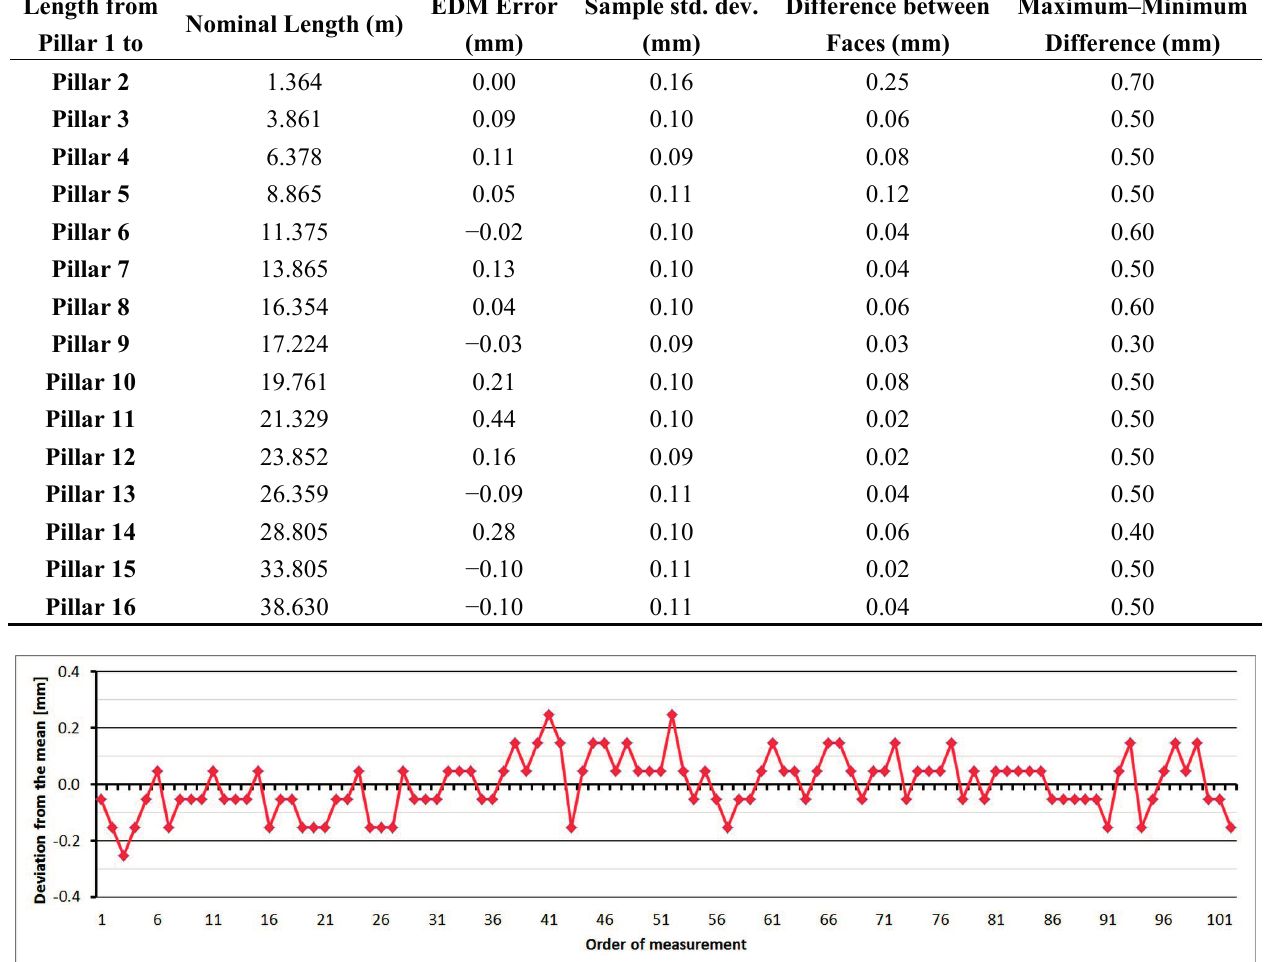
Table 4. Leica TC1202 (22 March 2014).